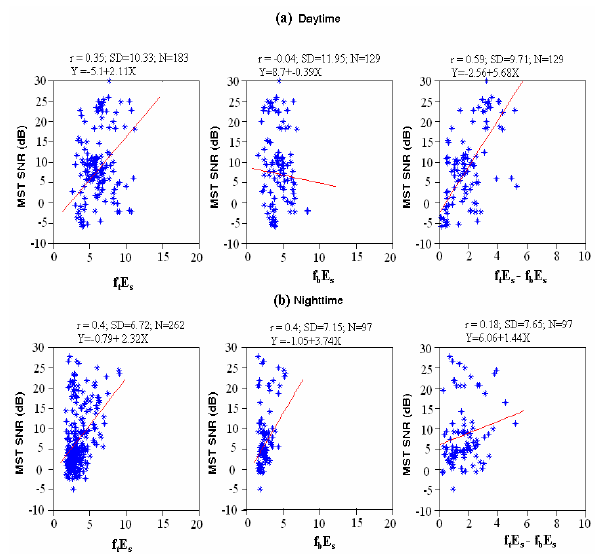
Fig. 6. Scatter plots of three E s parameters (f t E s , f b E s and f t E s – f b E s ) with FAI strength (SNR) for ( a ) daytime and ( b ) nighttime. The correlation coefficients and least-square fit lines are also